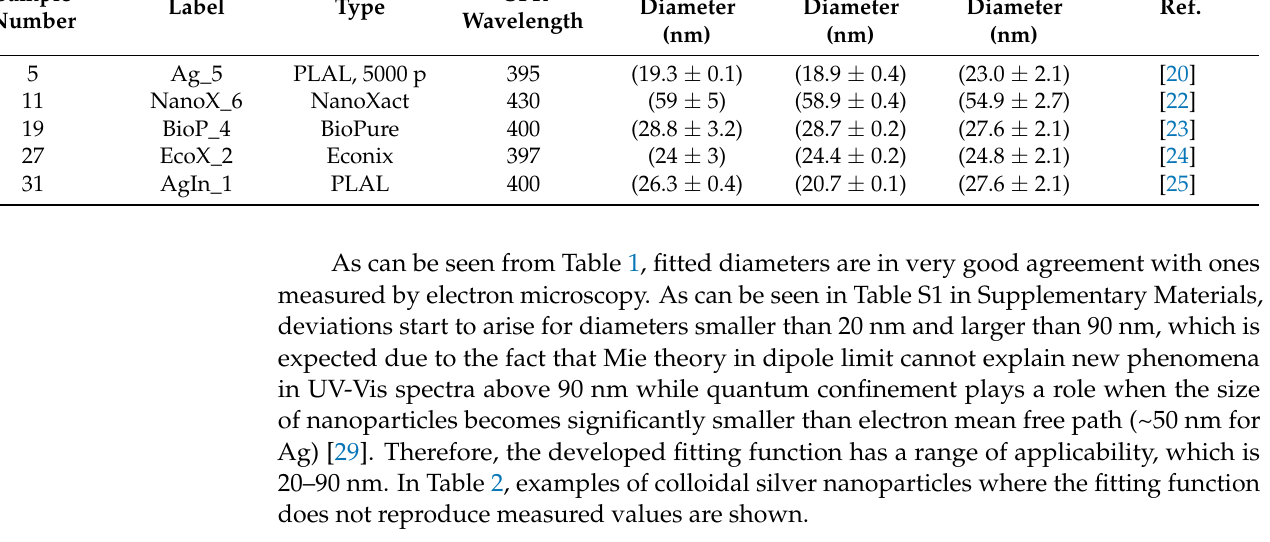
Table 2. List of labels, types, SPR wavelengths, measured, fitted, and expected diameters of colloidal silver nanoparticles for which the fitting function does not reproduce measured values.